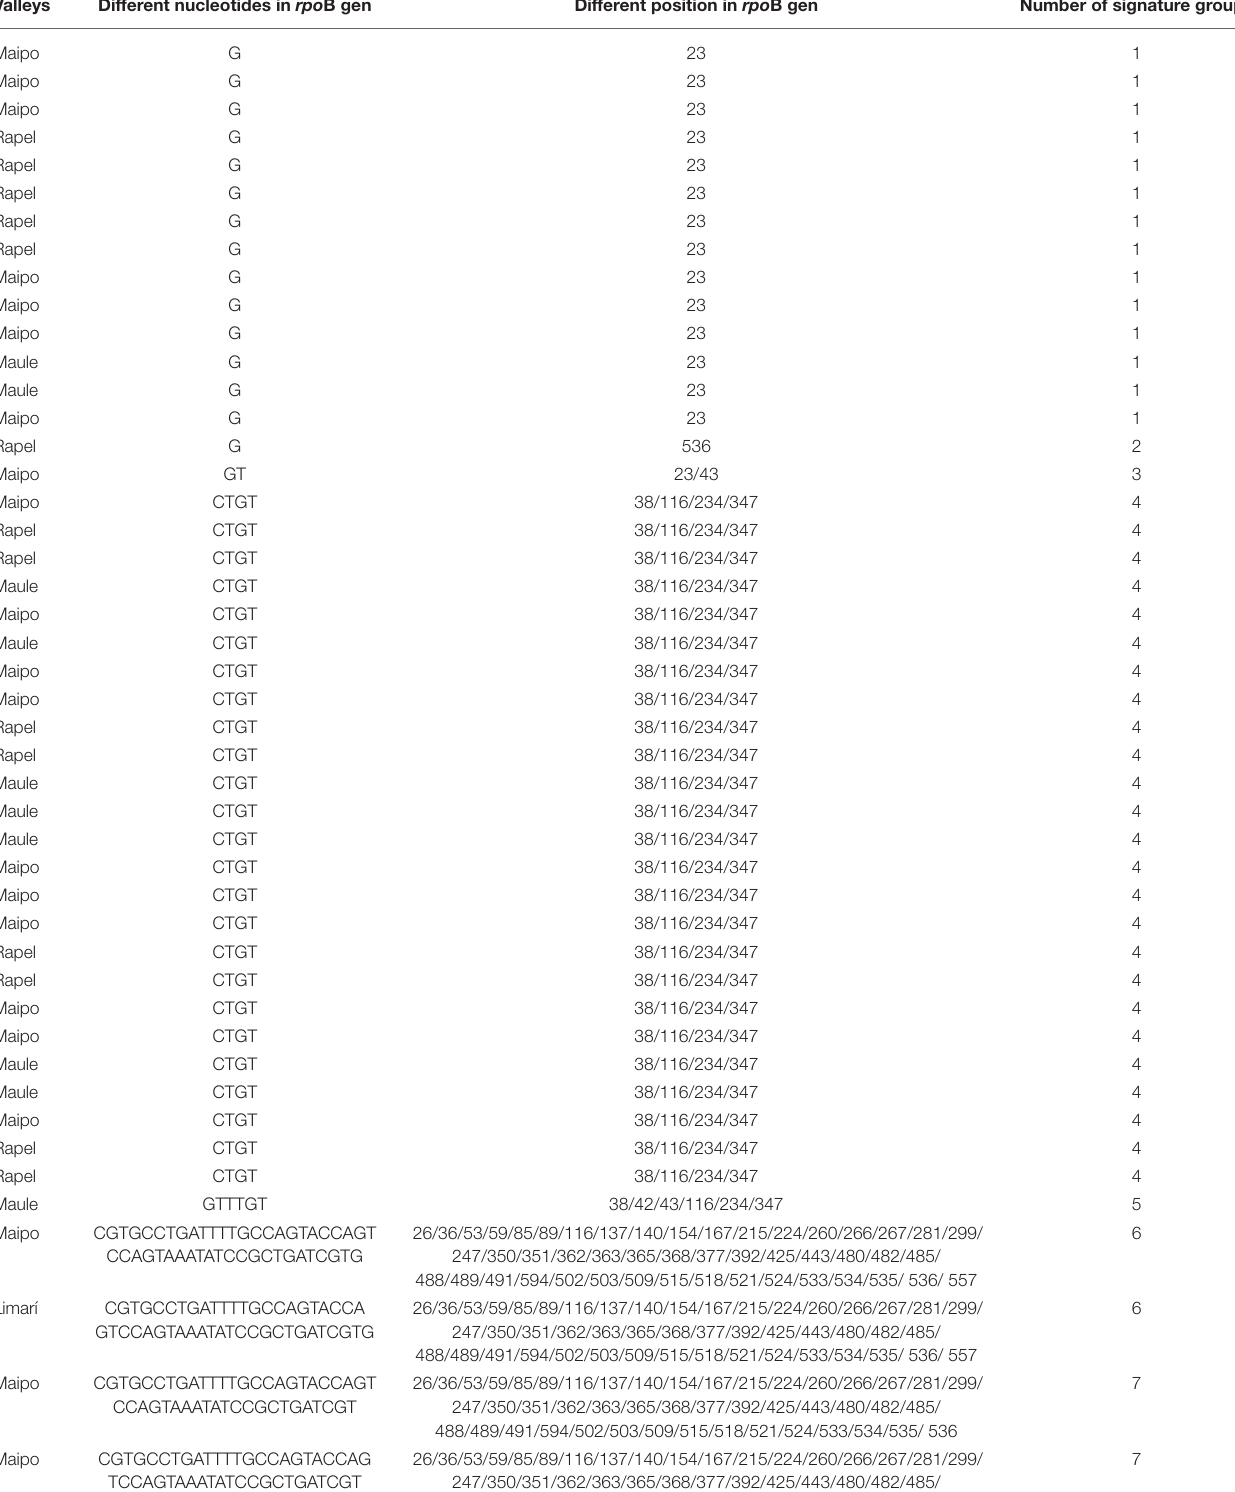
TABLE 2 | Signature groups of autochthonous O. oeni isolates from different valleys. Valleys Different nucleotides in rpo B gen Different position in rpo B gen Number of signature